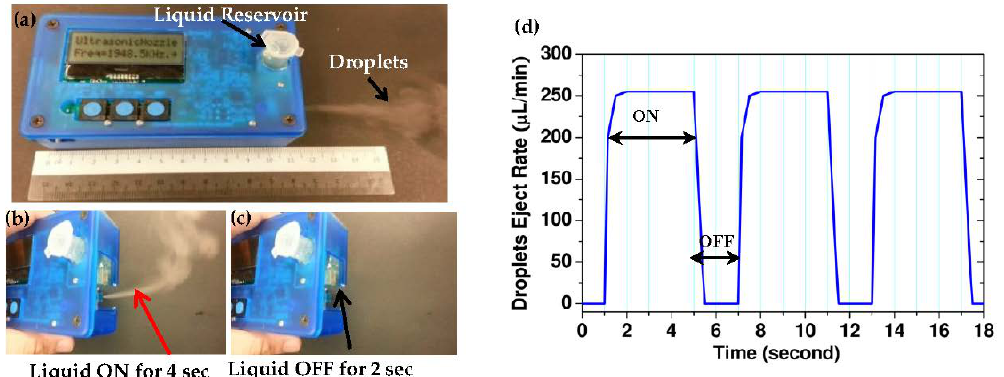
Figure 10. Battery-run pocket-size integrated ultrasonic micro droplet generator with electronically controlled ON/OFF capability: ( a ) the stand-alone unit; ( b ) nebulization turned ON; ( c ) nebulization turned OFF; and ( d ) nebulization ON/OFF time